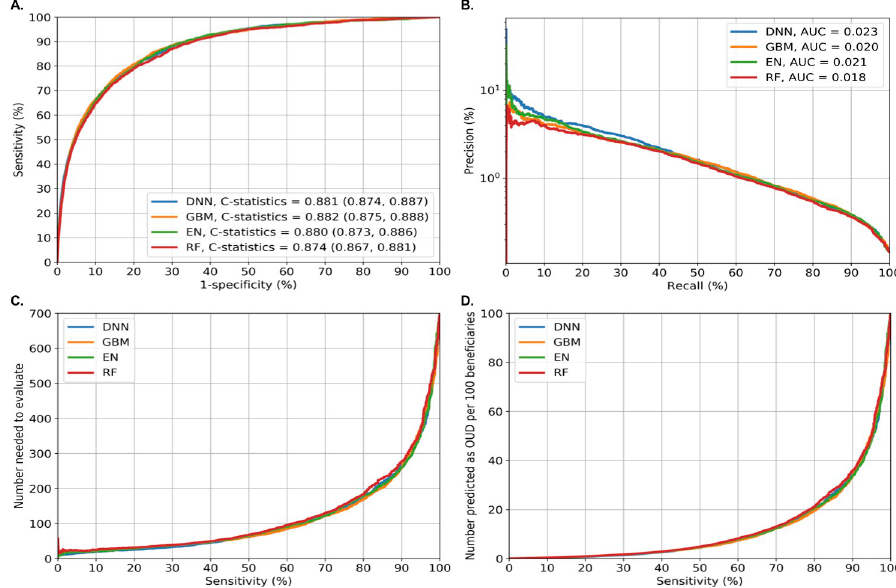
Fig 1. Performance matrix across machine learning models for predicting incident opioid use disorder in Medicare beneficiaries. Fig 1 shows four prediction performance matrices in the validation sample (120,497 beneficiaries with 1,298,189 non-OUD episodes and 1,869 OUD episodes). Fig 1A shows the areas under ROC curves (or C-statistics); Fig 1B shows the precision-recall curves (precision = PPV and recall = sensitivity): precision recall curves that are closer to the upper right corner or are above another method have improved performance; Fig 1C shows the number needed to evaluate by different cutoffs of sensitivity; and Fig 1D shows alerts per 100 patients by different cutoffs of sensitivity. Abbreviations: AUC: area under the curves; DNN: deep neural network; EN: elastic net; GBM: gradient boosting machine; RF: random forest; ROC: Receiver Operating